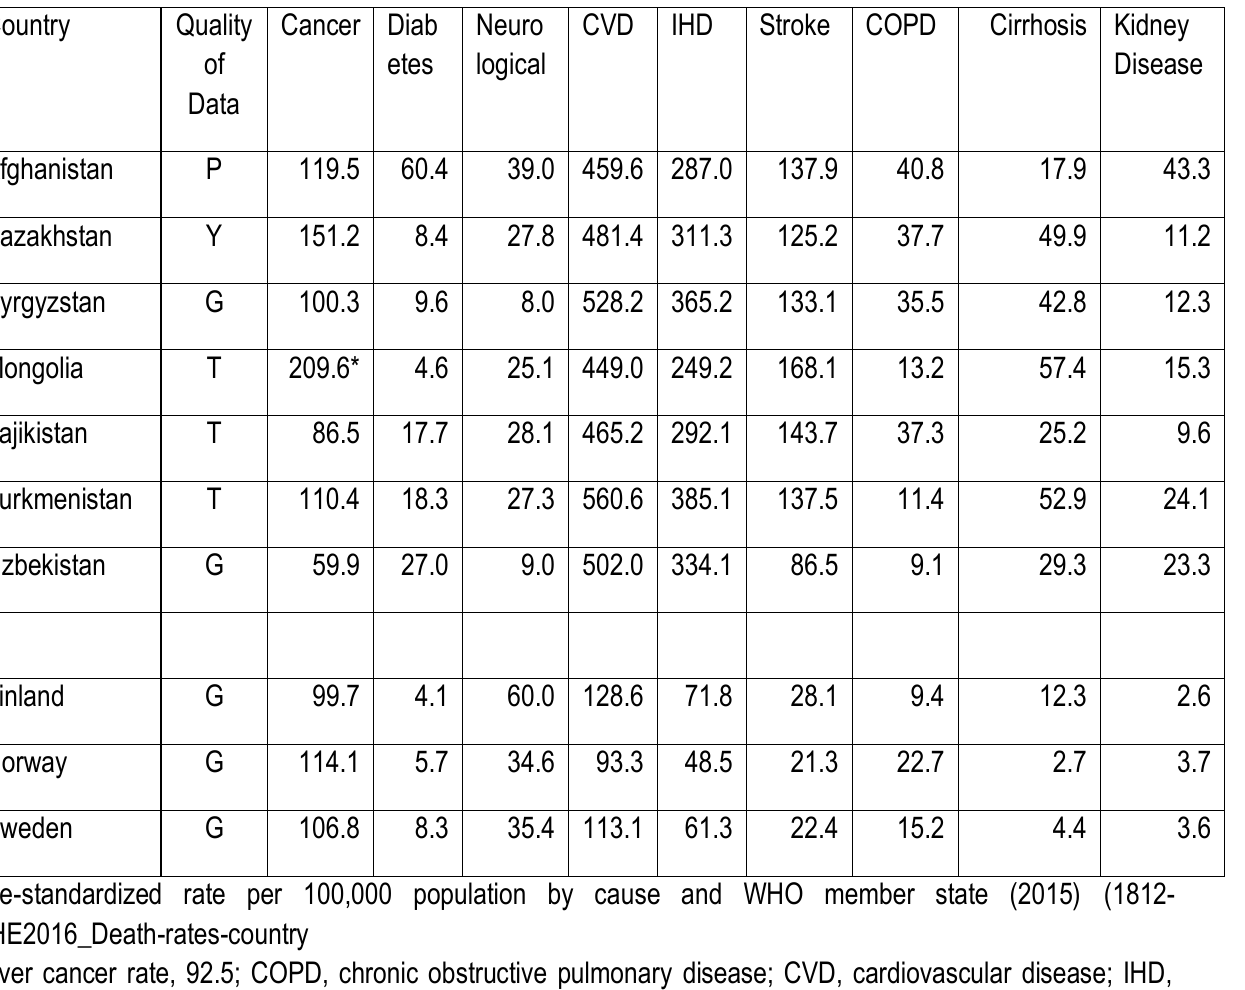
Table 2. Mortality rate data by country for various causes, 2015 [4]